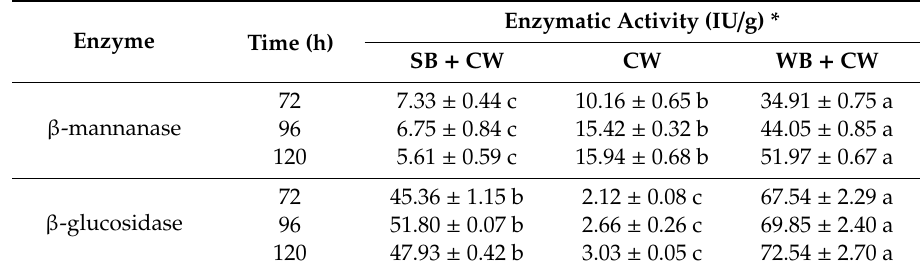
Table 1. Enzymatic activities of β -mannanase and β -glycosidase obtained for SSF with A. niger F12